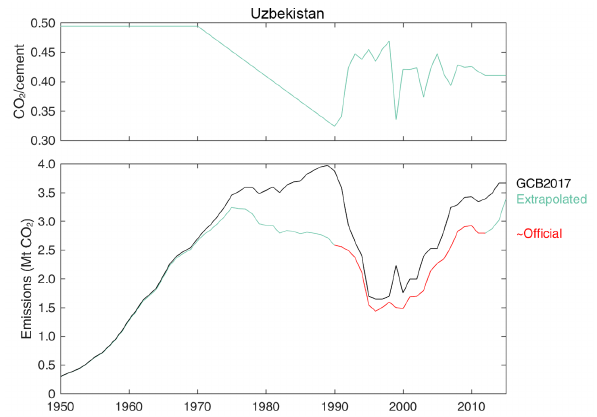
Figure C37. Revised cement emissions in